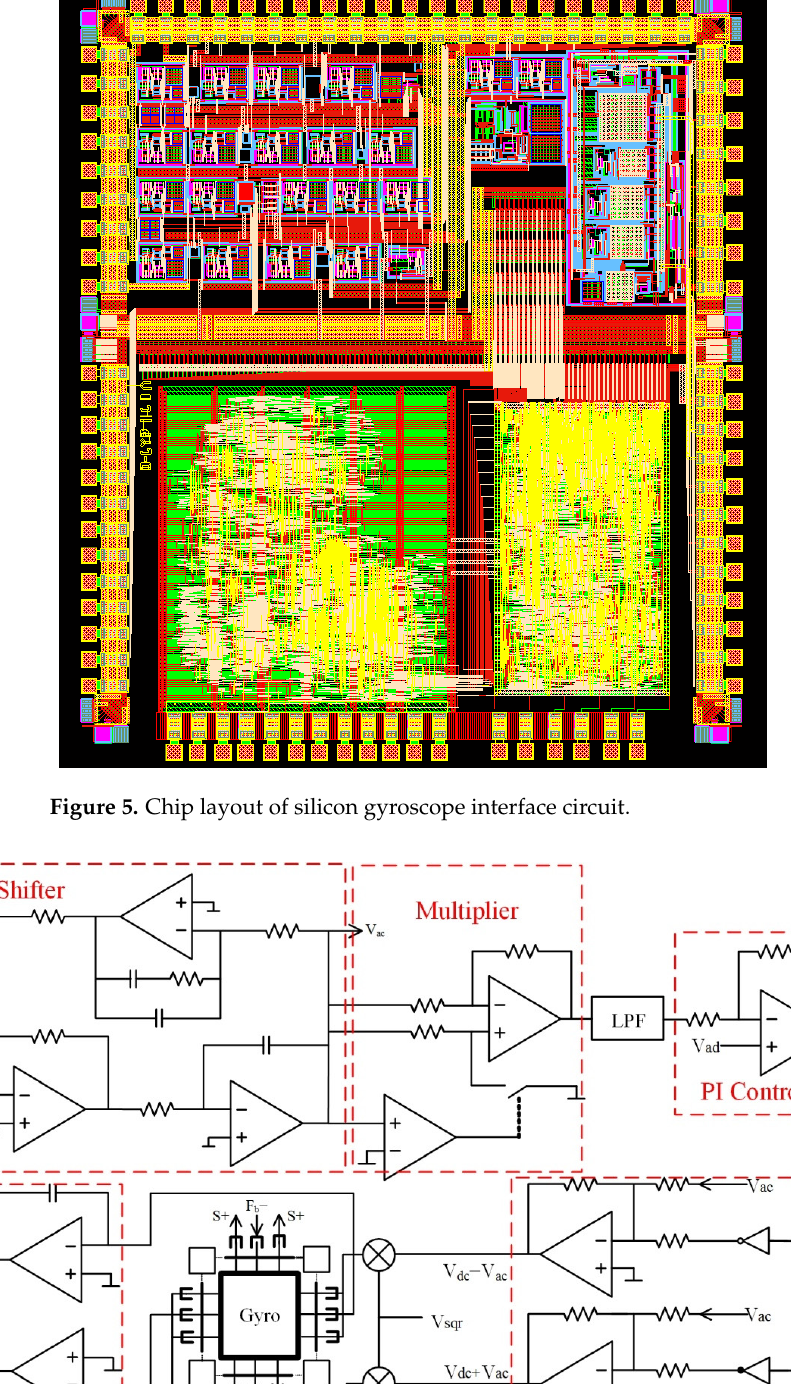
Figure 4. Schematic diagram of the zero pole of the drive loop.